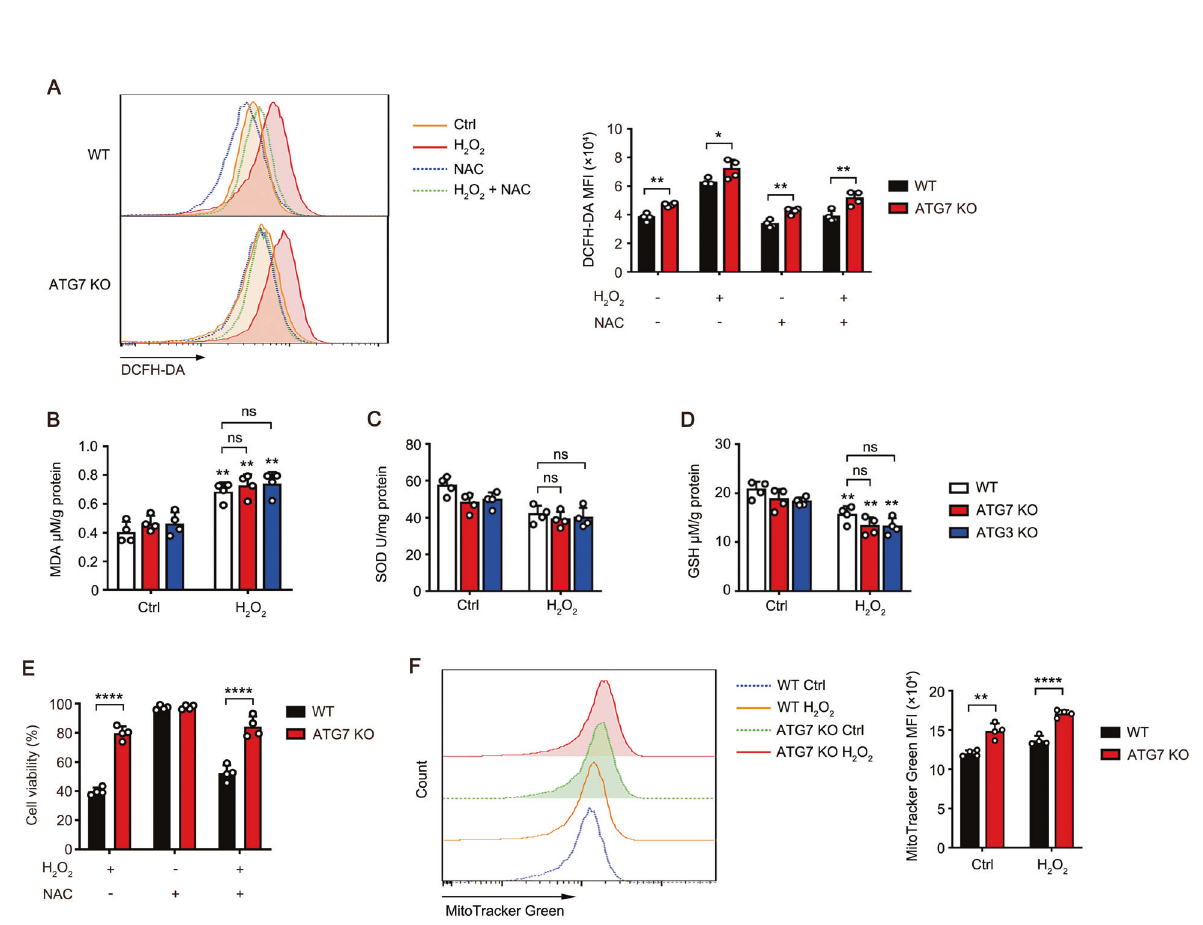
Fig. 3 Autophagy facilitates apoptosis of LECs independent of ROS. A Representative ROS levels in WT and ATG7 KO HLE-B3 cells pretreated with 10 mM NAC for 1 h, followed by 200 μ M H 2 O 2 stimulation for 24 h assessed by fl ow cytometry using the ROS sensor DCFH-DA (left). Right panel, quantitative data from four independent experiments (mean ± SD; * p < 0.05, ** p < 0.01, unpaired Student ’ s t test). MDA ( B ), SOD ( C ), and GSH ( D ) levels in WT, ATG7, or ATG3 KO HLE-B3 cells with or without 200 μ M H 2 O 2 exposure for 24 h measured by respective kits (MDA level determined by TBRAS assay and normalized to protein concentration). Quantitative data are presented as mean ± SD from four independent experiments (** p < 0.01, H 2 O 2 -treated vs control group; two-way ANOVA followed by Bonferroni post hoc test). E Viability of WT and ATG7 KO HLE-B3 cells pretreated with or without 10 mM NAC for 1 h, followed by 200 μ M H 2 O 2 stimulation for 24 h determined by CCK8 assay. Mean ± SD from four independent experiments; ****p < 0.0001 (unpaired Student ’ s t test). F MitoTracker labeling and FACS analysis of mitochondrial mass in WT and ATG7 KO HLE-B3 cells with or without 200 μ M H 2 O 2 exposure for 24 h. Right panel, quantitative data from four independent experiments (mean ± SD; ** p < 0.01, **** p < 0.0001, unpaired Student ’ s t test). more durable than in WT cells (Fig. 4E, F). As expected, knockdown of p65 with two different RNAi sequences both signi fi cantly protein Bax remained unchanged (Fig. 4C, D). Moreover, the phosphorylation of NF- κ B p65 and I κ B as well as translocation of